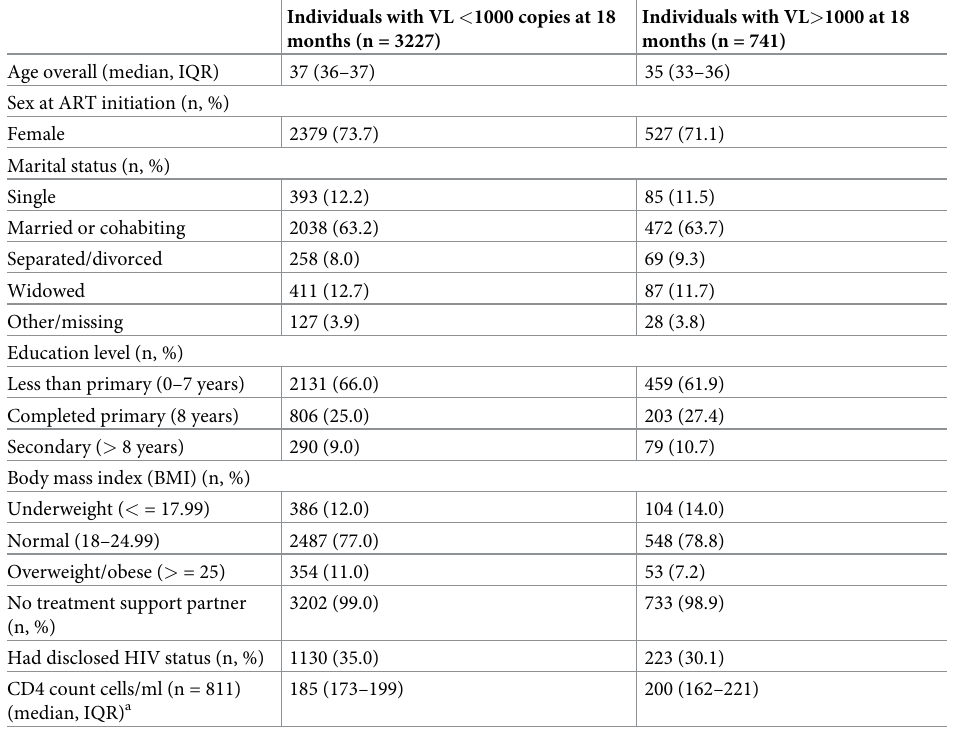
Table 1. Participant